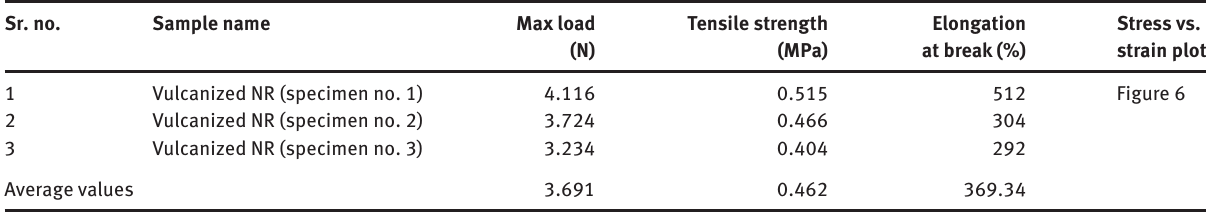
Table 4: Mechanical properties of vulcanized NR after cold resistance at − 60 ° C for 8 h. Sr.